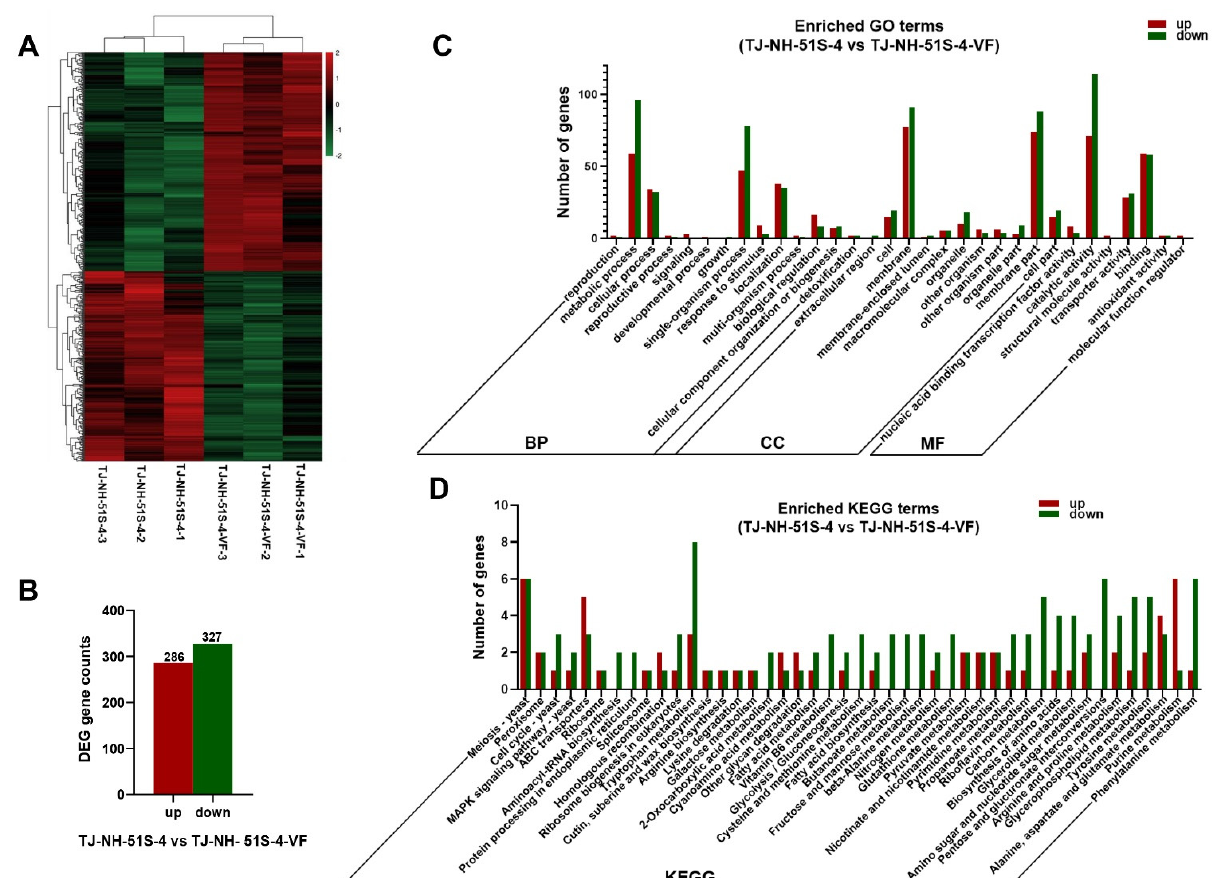
Figure 4. Transcriptional analyses of differentially expressed genes (DEGs) in Alternaria tenuissima strains TJ-NH-51S-4 and TJ-NH-51S-4-VF. ( A ) Hierarchical clustering of DEGs in strains TJ-NH-51S-4 and TJ-NH-51S-4-VF. Red and green colors indicate varying degrees of up-regulated and down- regulated genes, respectively. Expression key is indicated on the upper right side of the figure. ( B ) A total of 613 DEGs were identified, of which 286 DEGs were up-regulated, and 327 DEGs were down-regulated. ( C ) Gene Ontology (GO) classification analysis of DEGs in strains TJ-NH-51S-4 and TJ-NH-51S-4-VF. ( D ) Kyoto Encyclopedia of Genes and Genomes (KEGG) pathways classification analysis of DEGs in strains TJ-NH-51S-4 and